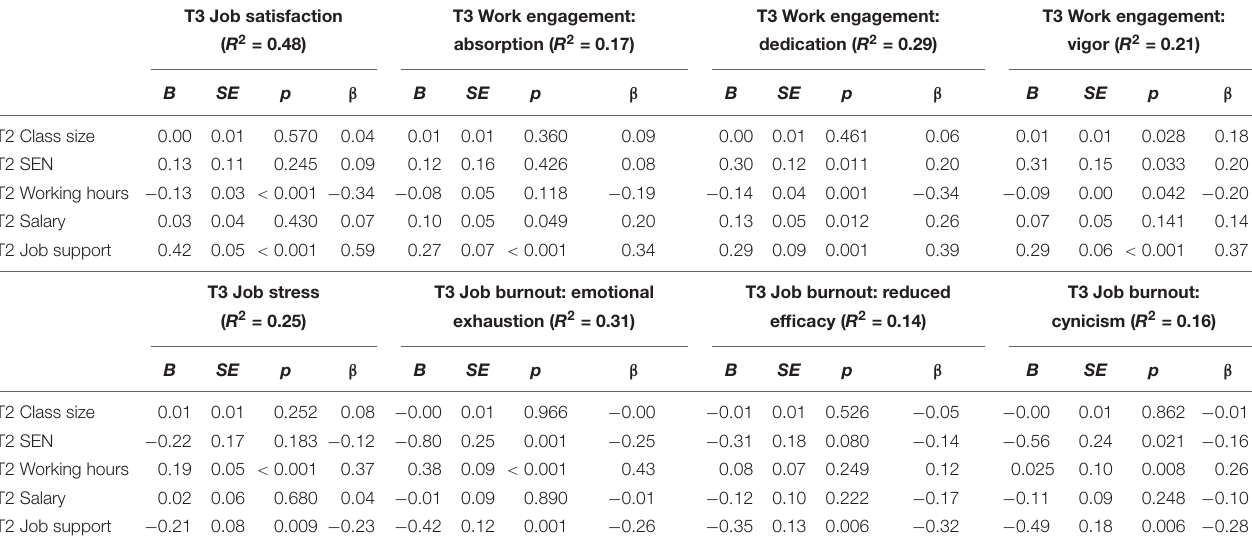
TABLE 2 | Regression of OWB indicators on job demands and job